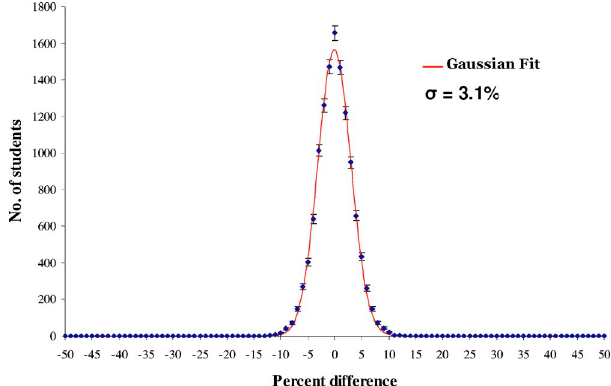
FIG. 1. (cid:1) Color (cid:2) Percent difference in the students’ even and odd test scores. Items were split based on item difficulty.